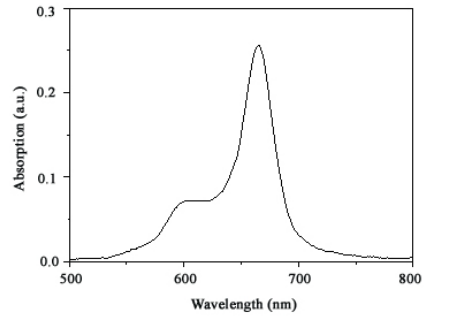
Figure 2. UV-vis absorption spectra of T α PcZn in DMSO/water (1:3, v/v) mixtures.